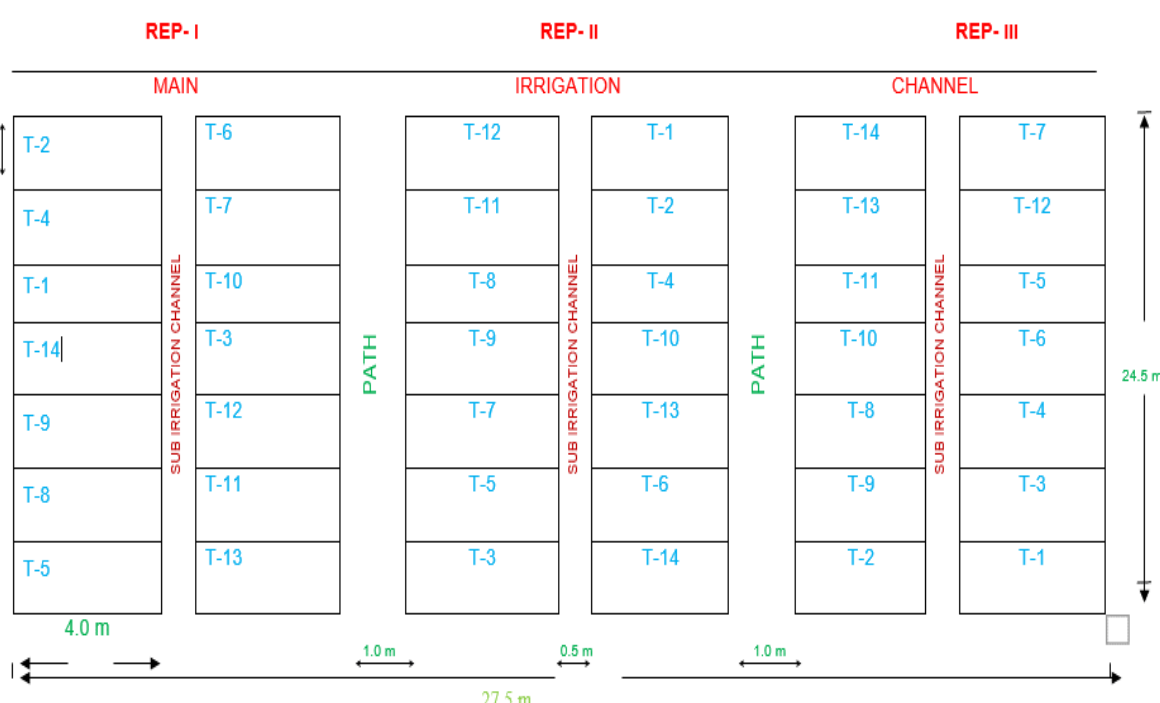
Figure 1. Detailed layout of the conducted experiment.